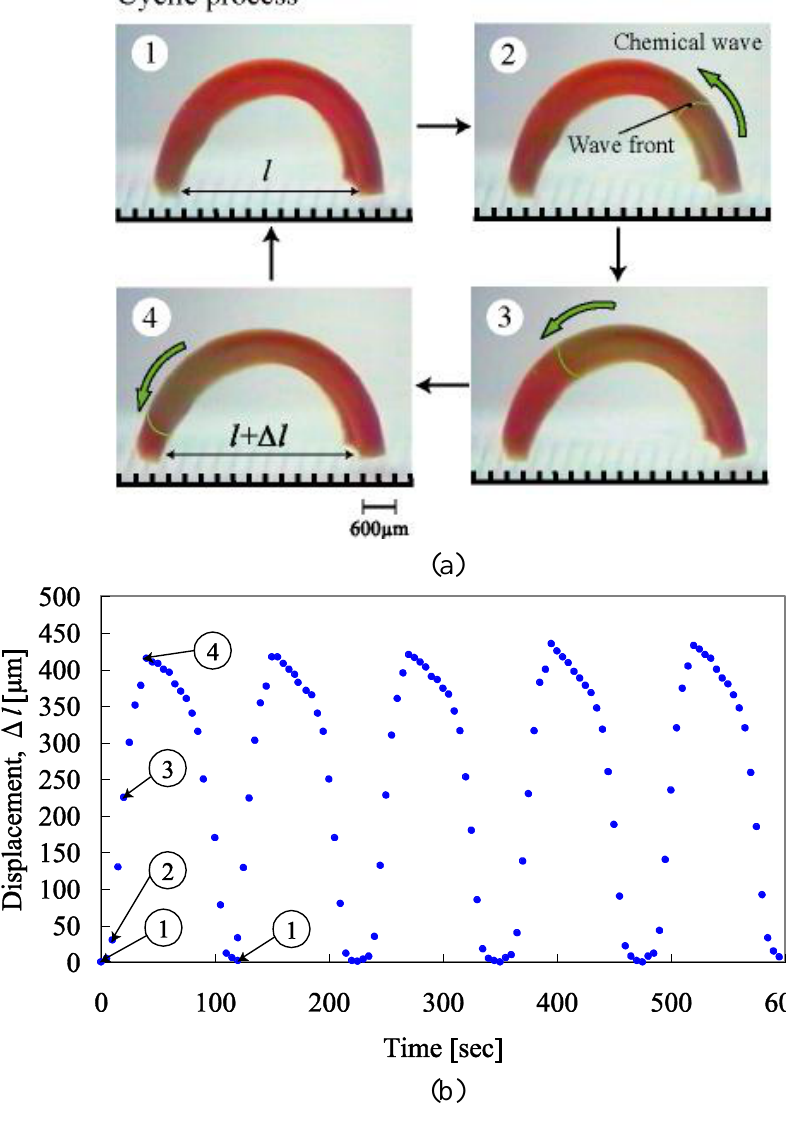
Figure 1. ( a ). Equilibrium swelling ratio expressed as curvature of the poly(NIPAAm- co - Ru(bpy) -co- AMPS) gel strip in cerium sulfate solutions as a function of temperature. Closed 3 square: Ce (SO ) = 0.005 M and HNO = 0.894 M; Open square: Ce(SO ) = 0.005 M and 2 4 3 3 4 2 HNO = 0.894 M. The curvature is defined as 1/R. S. Maeda et al. Self-walking gel. 3 Adv. Mater. 2007 , 19 , 3480-3484. Copyright Wiley-VCH Verlag GmbH & Co.KGaA. Reproduced with permission. ( b ). Oscillating profiles of the bending-stretching motion for the gel. l is the direct distance between two edges of the curved gel strip at reduced state. ∆ l is the displacement of the direct distance when chemical wave propagates in the gel. S. Maeda et al. Self-walking gel. Adv. Mater. 2007 , 19 , 3480-3484. Copyright Wiley-VCH Verlag GmbH & Co.KGaA. Reproduced with permission. ( c ). Dependence of amplitude (the maximum of displacement, ∆ l ) on temperature. S. Maeda et al. Self-walking gel. max Adv. Mater. 2007 , 19 , 3480-3484. Copyright Wiley-VCH Verlag GmbH & Co.KGaA. Reproduced with